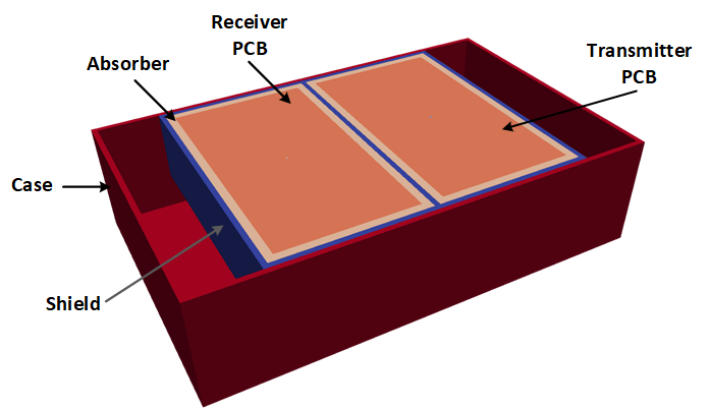
Figure 5. gprMax model of the 1.5-GHz antenna from GSSI Inc. The antenna dimensions are 17 cm × 10.8 cm × 4.3 cm (L × W × H). The skid plate underneath the casing has been removed to show the inside of the